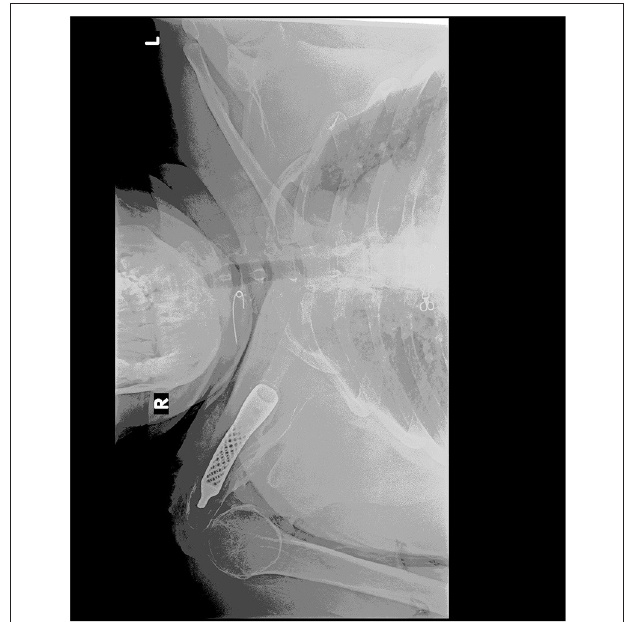
FIGURE 7 | Postoperative radiograph at 2-year follow-up revealed a good position of the prosthesis.